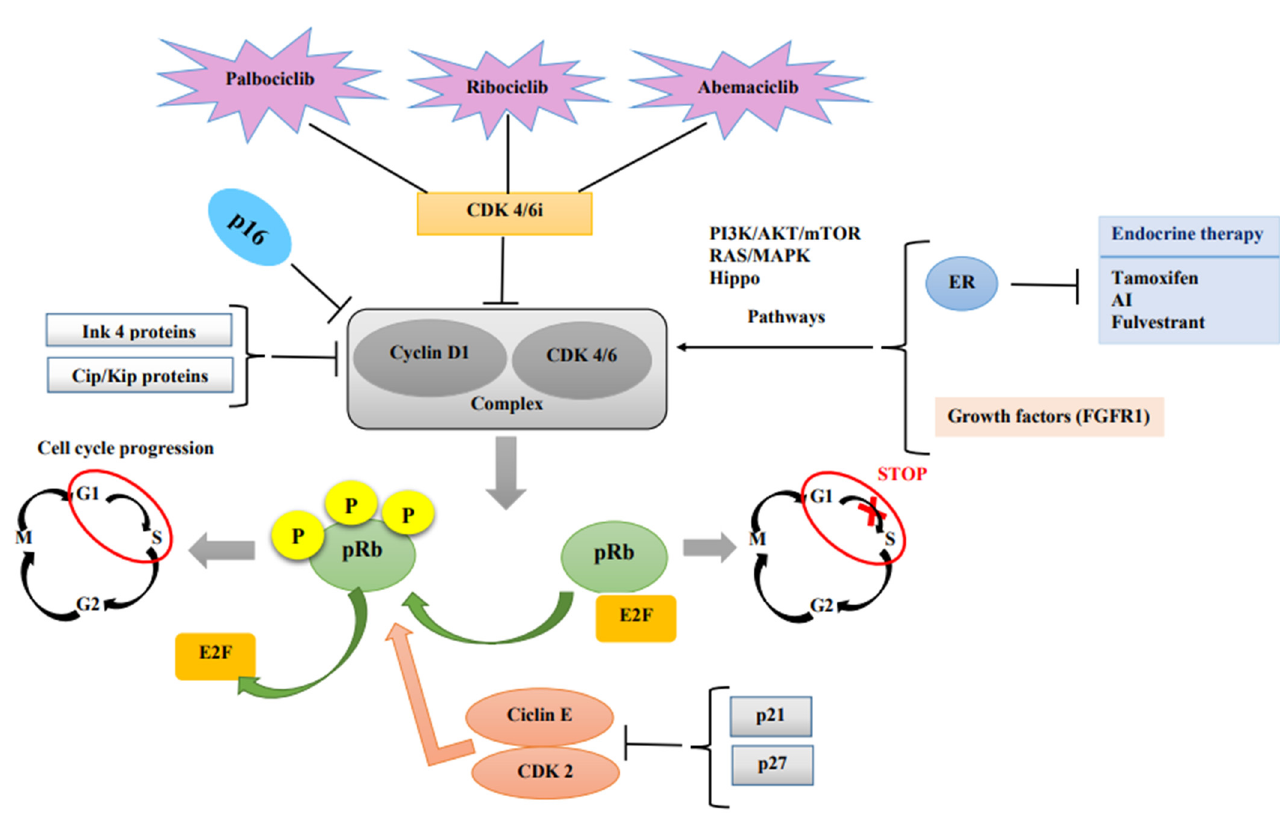
Figure 1. Key mechanisms of action of CDK4/6 inhibitors in HR+/HER2- breast cancer.